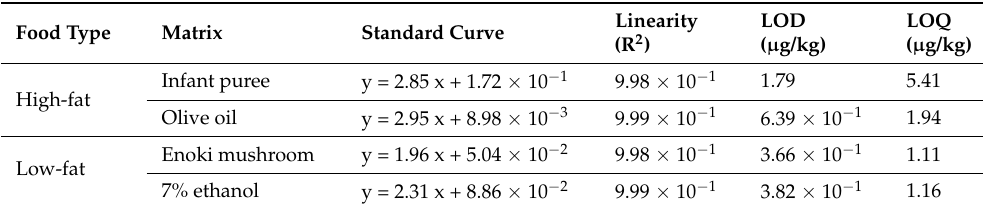
Table 2. Linearity, LOD, and LOQ for 4-n-NP in food matrices. Food